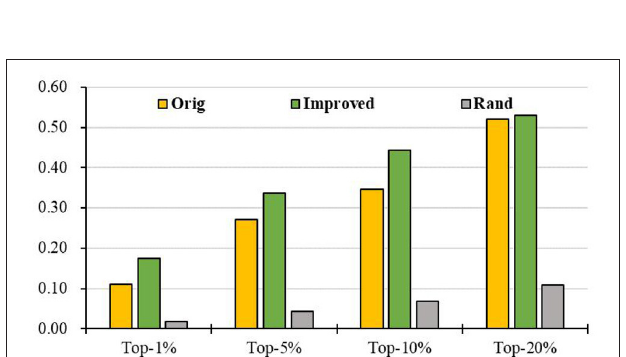
FIGURE 4 | Top- k Recall ( k 1, 5, 10, 20%) of the original and improved = algorithms in the PPI network.